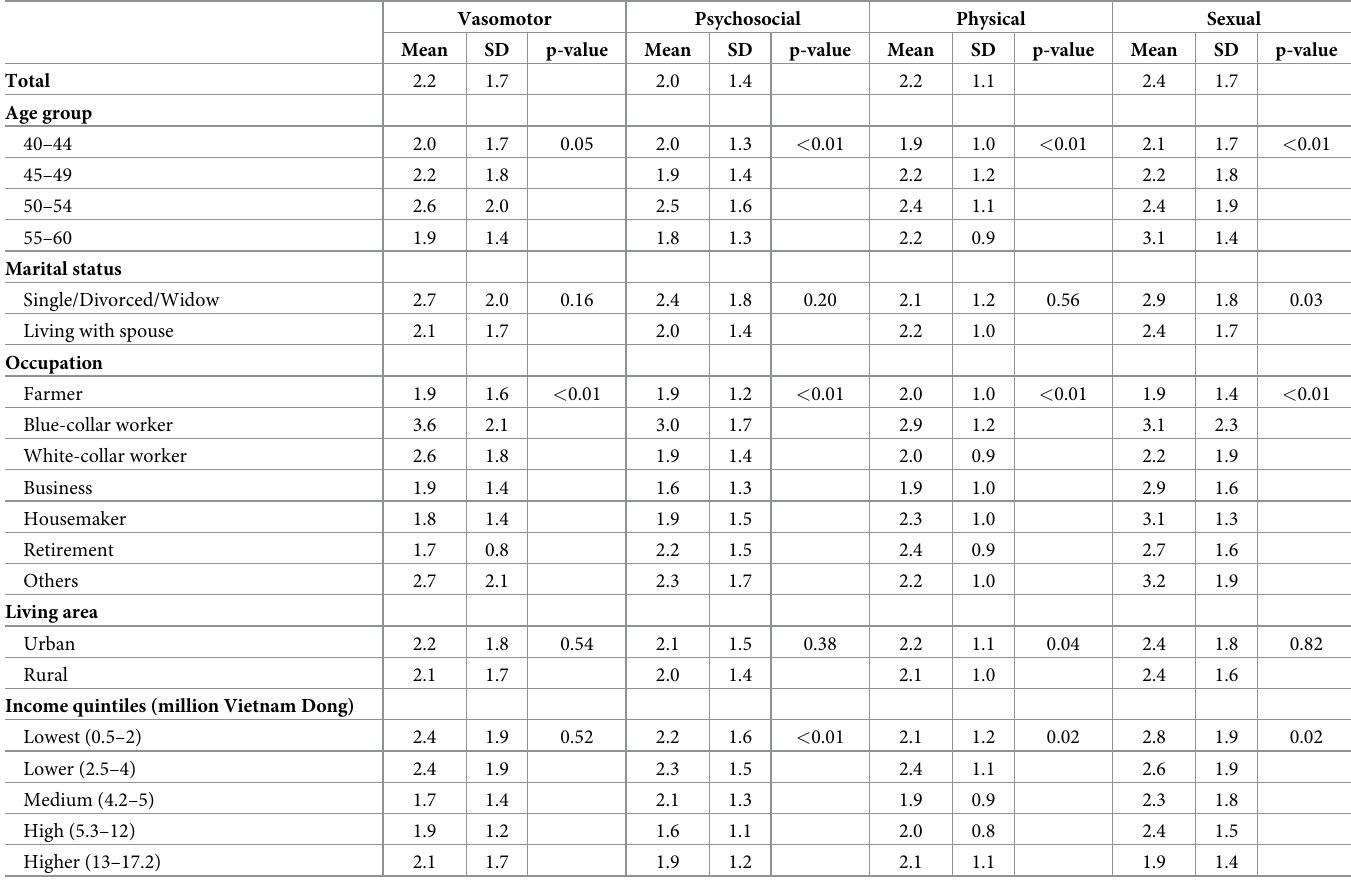
Table 3. MENQOL domain scores in perimenopausal middle-age women according to different